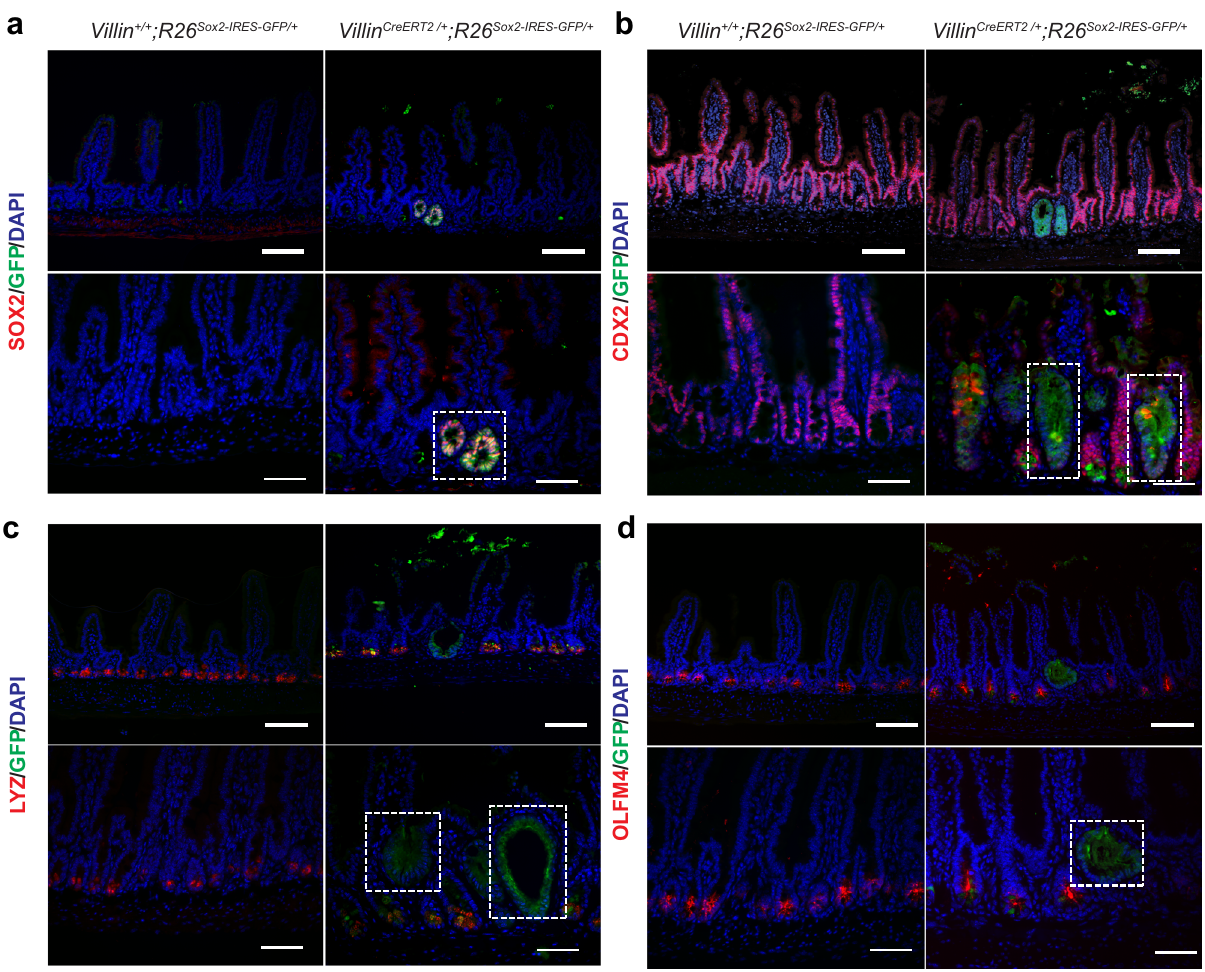
Fig. 5 Sox2 overexpression impairs intestinal identity in adult homeostasis. a – d Immuno fl uorescence images of Villin + / + ; R26 Sox2-IRES-GFP + ( n = 3, left) and Villin CreERT2/ + ; R26 Sox2-IRES-GFP ( n = 4, right) for a SOX2 (red) and GFP (green), b CDX2 (red) and GFP (green), c Lysozyme C (LYZ, red) and GFP (green), and d OLFM4 (red) and GFP (green). Scale bars of a – d are 100 µ m for top panels and 50 µ m for bottom panels. White dotted boxes indicate areas of GFP